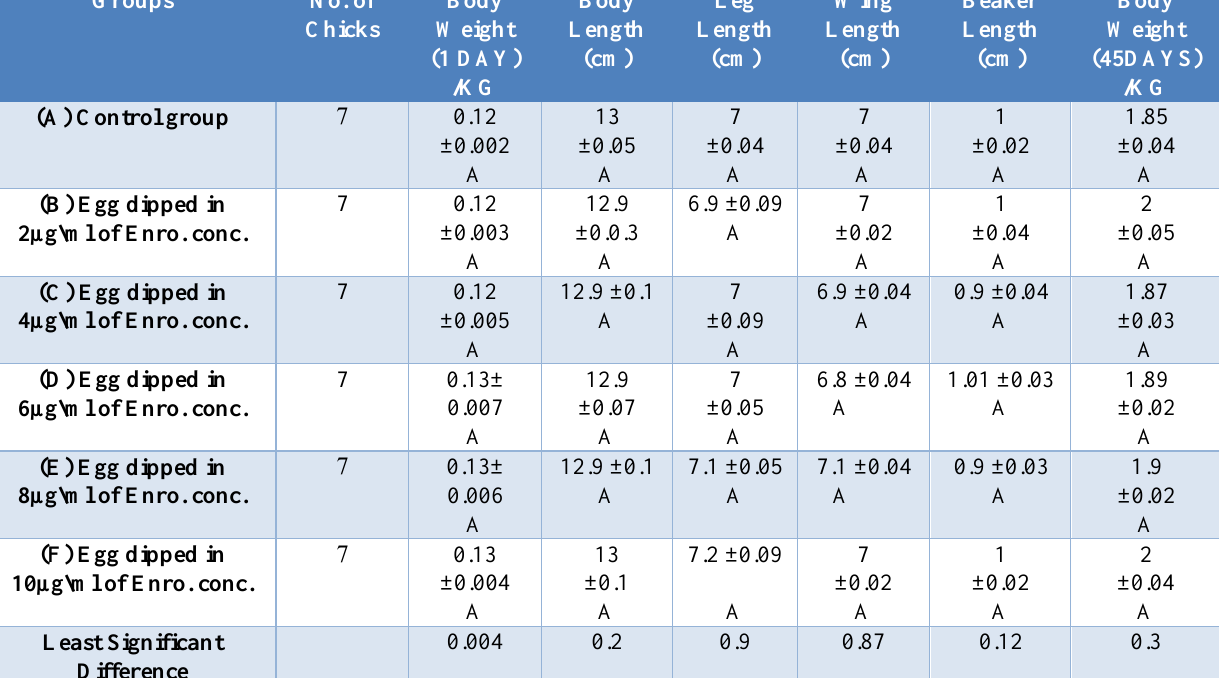
Table (4): Teratogenic effects of different concentration of Enrofloxacin were assessed by observing the following parameters